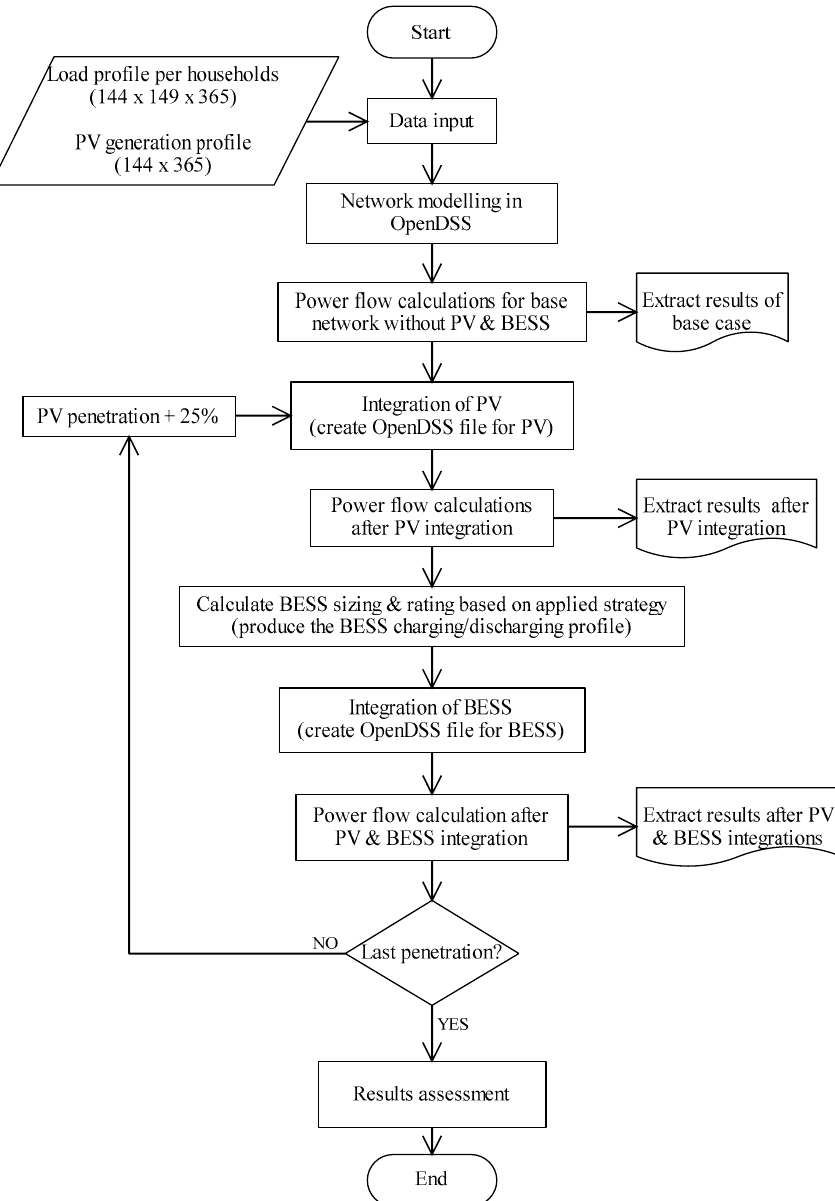
Figure 10. The implementation flowchart of PV and BESS allocation.